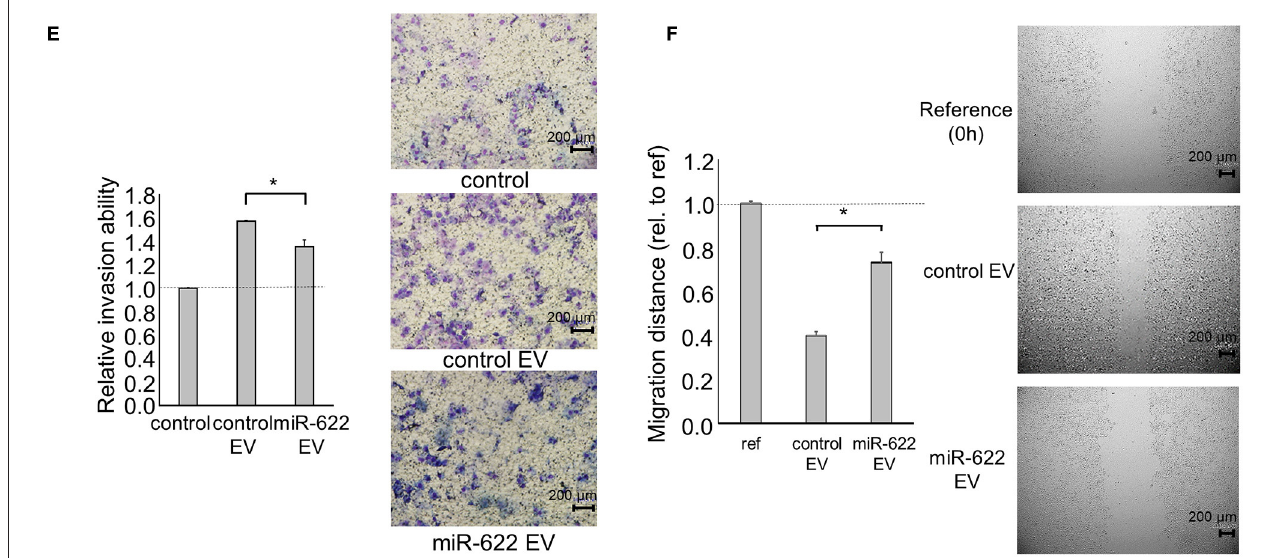
FIGURE 6 | Intercellular miR-622 transfer by EVs during EMT and the phenotype of PDAC cells. Panc-1 cells (1 × 10 6 ) were plated in 10ml of vesicle-depleted medium on 10-cm dishes and were transfected with 12.5nM miR-622 or the control mimic. After incubation for 72h, EVs were extracted from the conditioned medium by ultracentrifugation. (A) Transmission electron microscopy was performed on EVs isolated from Panc-1 cells. Obtained EVs were composed of a homogeneous population of particles. (B) EV RNA was isolated and miR-622 or HULC expression was assessed by qRT-PCR. (C–F) EVs were added to recipient Panc-1 cells. (C) After 48h, RNA was extracted from recipient cells and expression of miR-622, HULC, E-cadherin, N-cadherin, vimentin, and Snail was examined by qRT-PCR. RNA expression was normalized to that of U6 and expressed relative to the value of the control. (D) After 72h, protein was extracted, and western blotting for E-cadherin, N-adherin, vimentin, and Snail was performed. Protein levels were normalized to that of β -actin. (E) After 24h, cell invasion was examined by Transwell assay using an inverted microscope. (F) After 24h, cell migration was examined by wound healing assay. Reference indicates the image at time 0. Bars are the means ± SEM of three independent experiments. * P < 0.05.